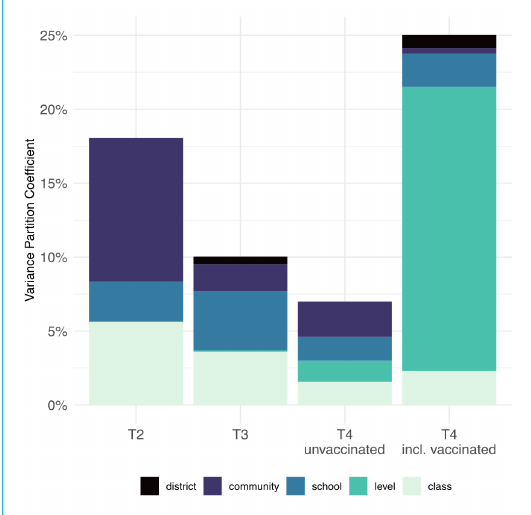
Figure 3: Composite variability in seroprevalence of children and adolescents at T2 (October–November 2020), T3 (March–April 2021) and T4 (November–December 2021) using variance parti- tion coefficients. The total length of the bars shows the total pro- portion of variance in seroprevalence explained by class, school level (primary versus secondary), school (ID), community, and dis- trict. The remaining residual variation is attributable to unmeasured